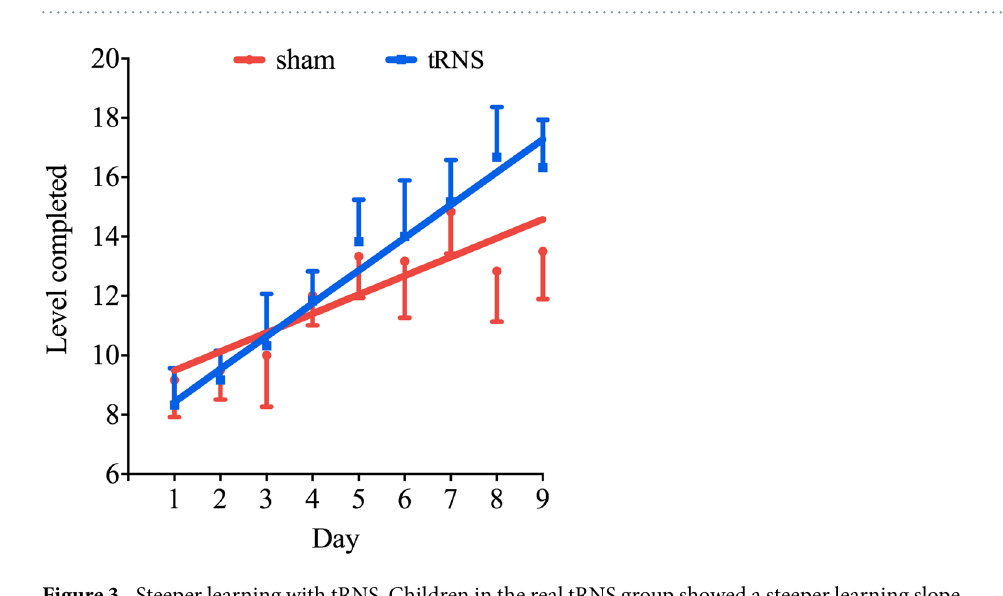
Figure 2. Improved accuracy with transcranial random noise stimulation (tRNS). Only children in the real tRNS group showed improved accuracy with training. Those in the sham group showed little improvement, characteristic of those with learning disabilities. ( a ) Bar graph indicates the mean accuracy of each group on each training day. Error bars indicate one standard error of the mean (SEM). ( b ) Scatter plot displays the mean accuracy of each individual on each training day, labelled according to group.